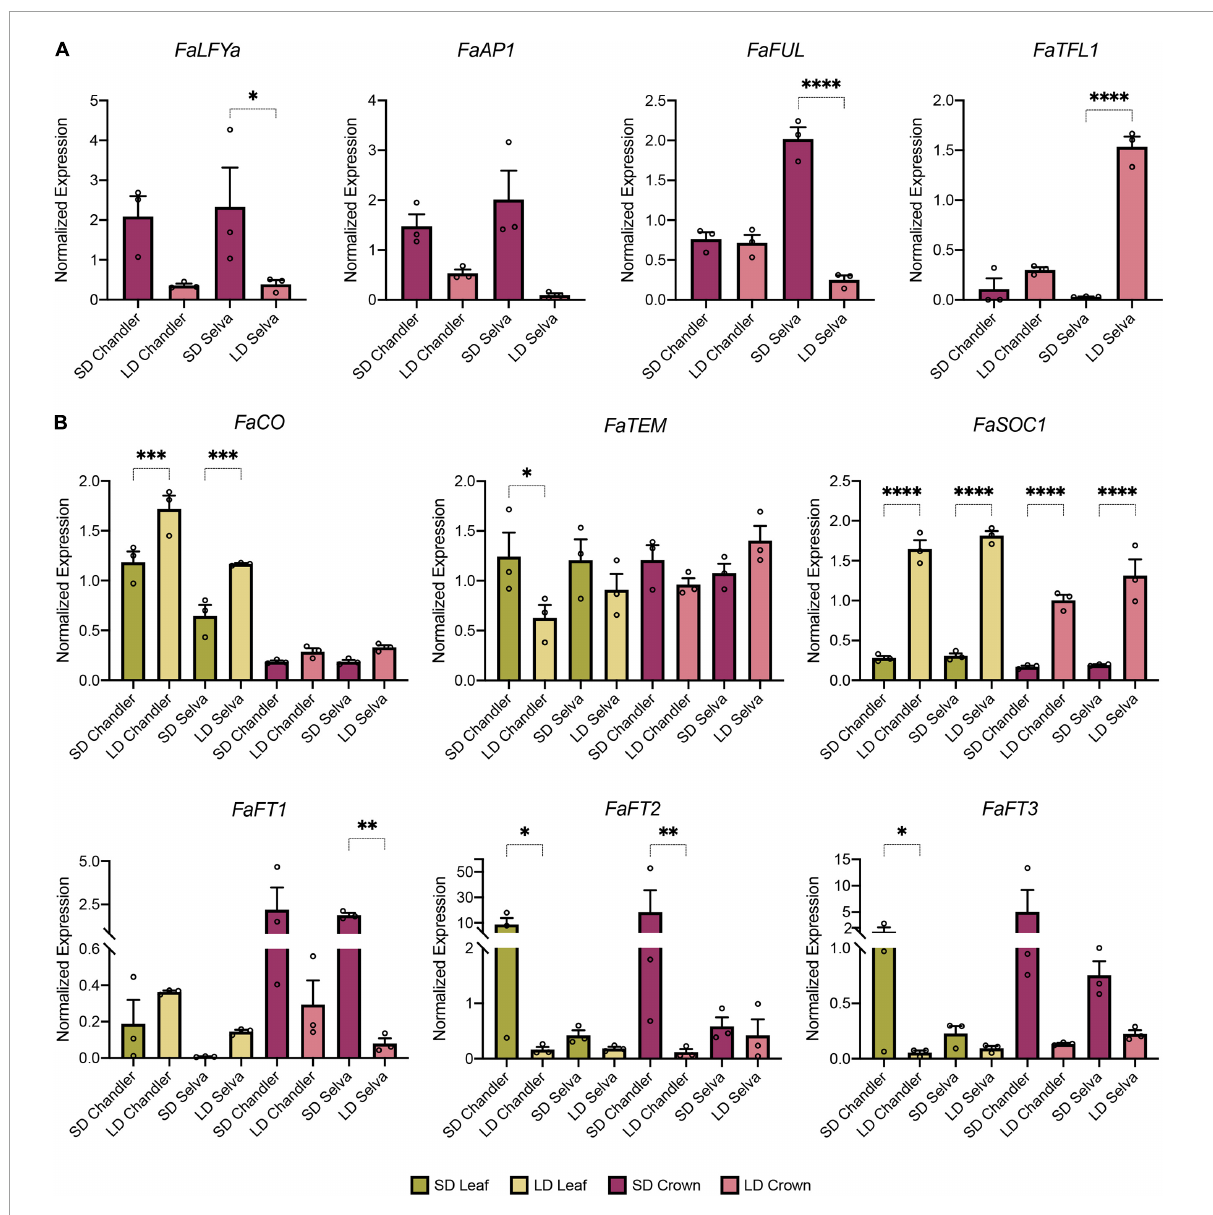
FIGURE1 Transcriptional response of flowering time genes to short (SD) and long (LD) days in the seasonal flowering (SF) cultivar Chandler and the perpetual flowering (PF) cultivar Selva. (A) Expression of floral meristem identity genes and FaTFL1 in crowns. (B) Expression of flowering time genes in leaves (green) and crowns (purple). Expression was analyzed by qRT-PCR. Graphs show the average of normalized values from three biological replicates ± SEM. In each bar, dots represent the normalized value of each biological replicate. * p < 0 . 05, ** p < 0 . 01, *** p < 0 . 001, **** p < 0 .